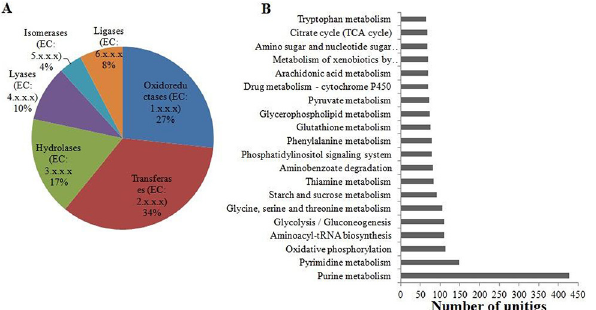
Fig 4. Enzyme classification and KEGG pathway mapping. (A) Percent distribution of different classes of enzymes mapped on whitefly unitigs. (B) Top twenty identified KEGG pathways.